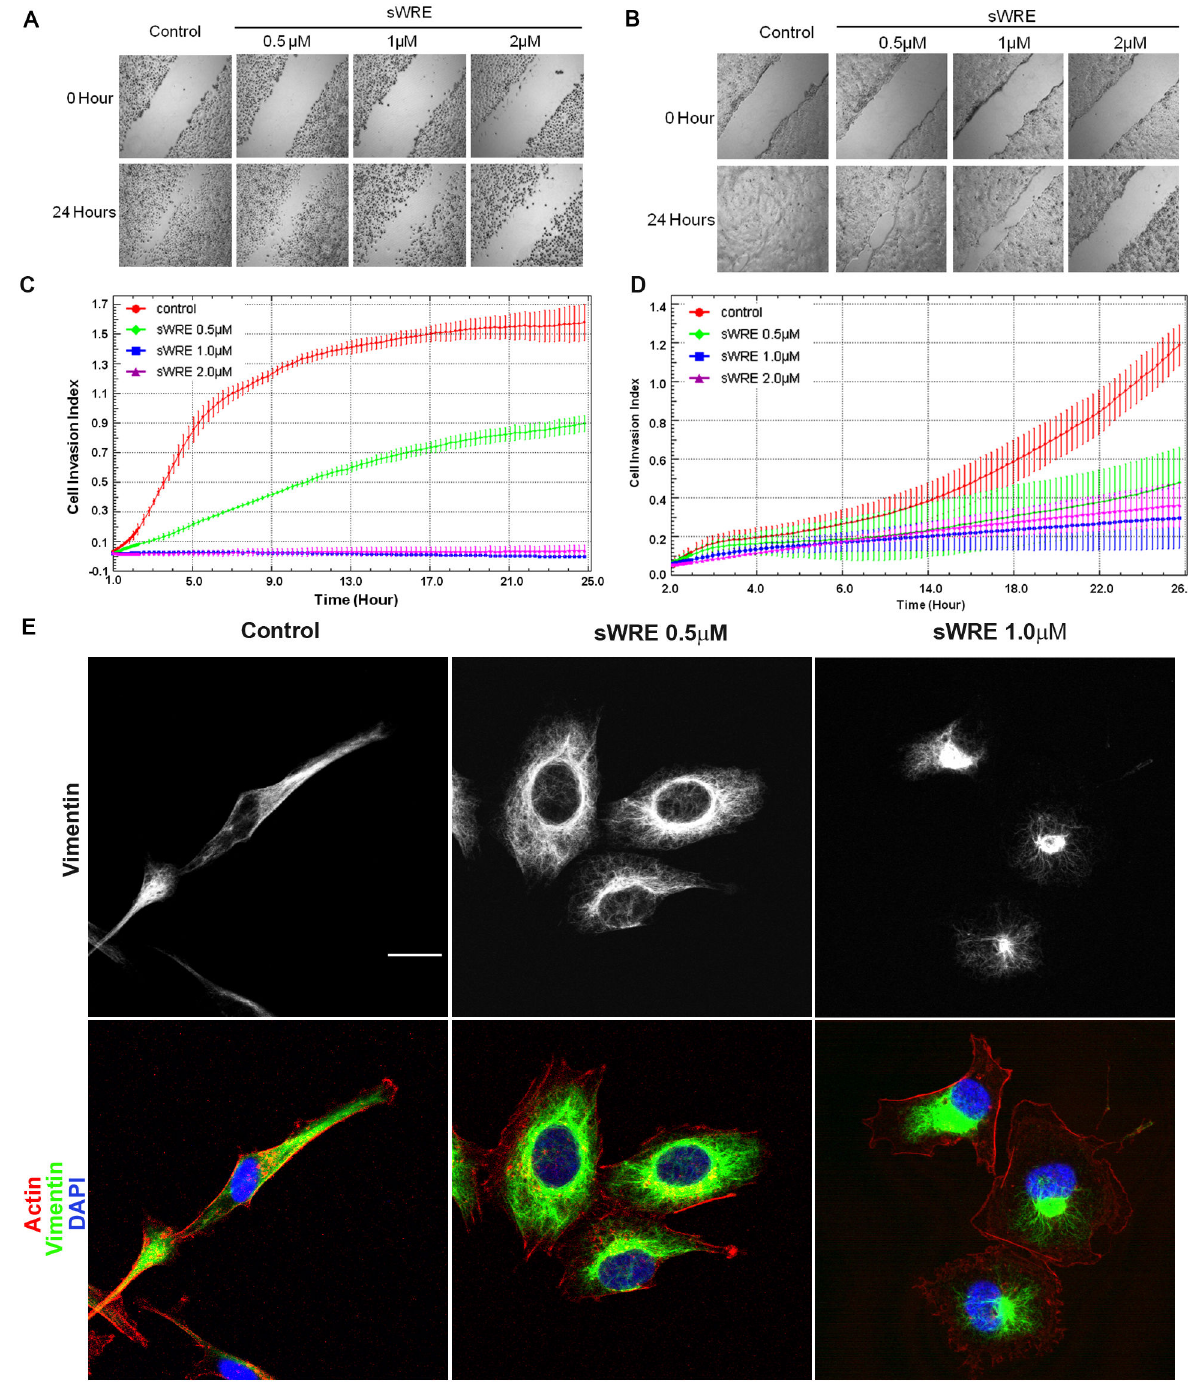
Figure 3. sWRE inhibits migration and invasion in MDA-MB-231 and 4T1 cell lines. (A and B) Cell wounding assay in (A) MDA-MB-231 and (B) 4T1 cells treated with increasing concentrations of sWRE for 24 hours. (C and D) Line graph showing the rate of cellular invasion through Matrigel embedded in a Boyden chamber in (C) MDA-MB-231 and (D) 4T1 cells treated with increasing concentrations of sWRE. (E) Confocal immunofluorescence imaging of vimentin (green), actin (red), and DAPI (blue) in MDA- MB-231 cells treated with 9% EtOH control, 0.5µM or 1.0µM sWRE.